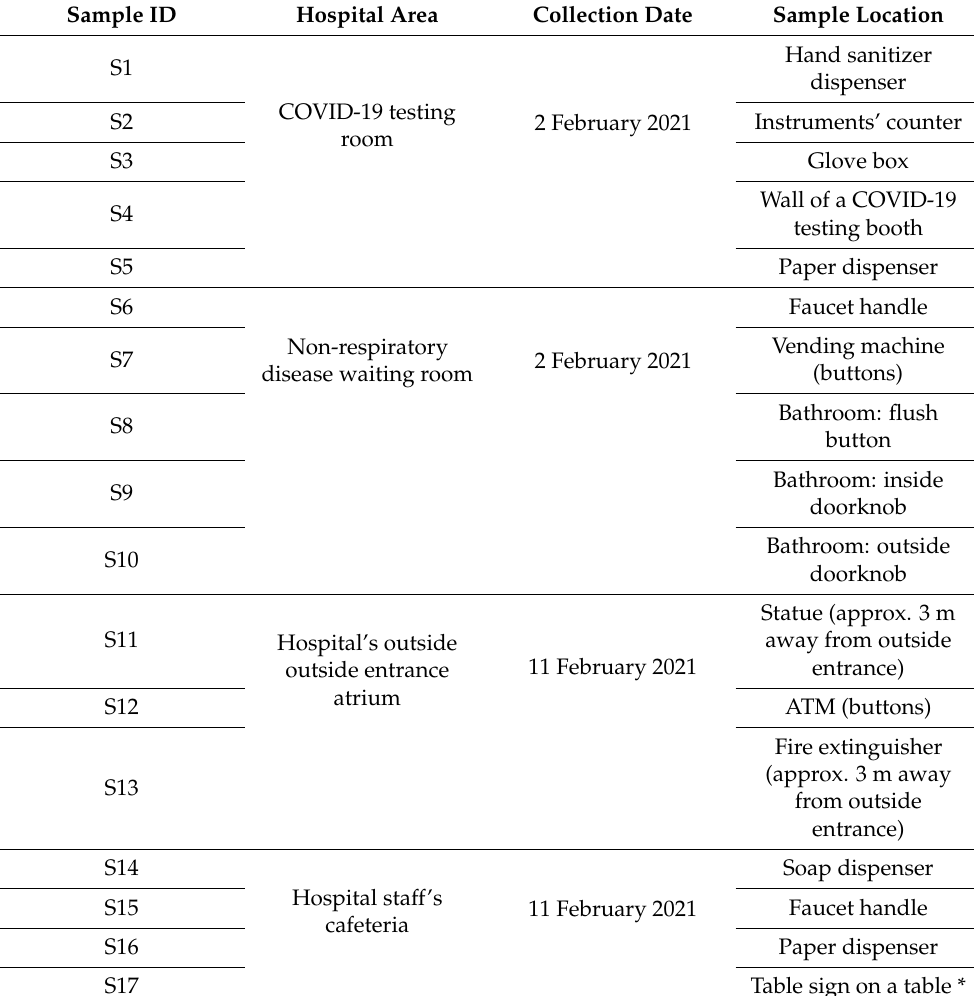
* Table sign: a sign with precautions to avoid contamination was placed on the table. RNA extraction and detection of SARS-CoV-2 RNA extraction was performed using the GRS Viral DNA/RNA Purification Kit (GRISP, Porto, Portugal) according to the manufacturer’s instructions. RNA